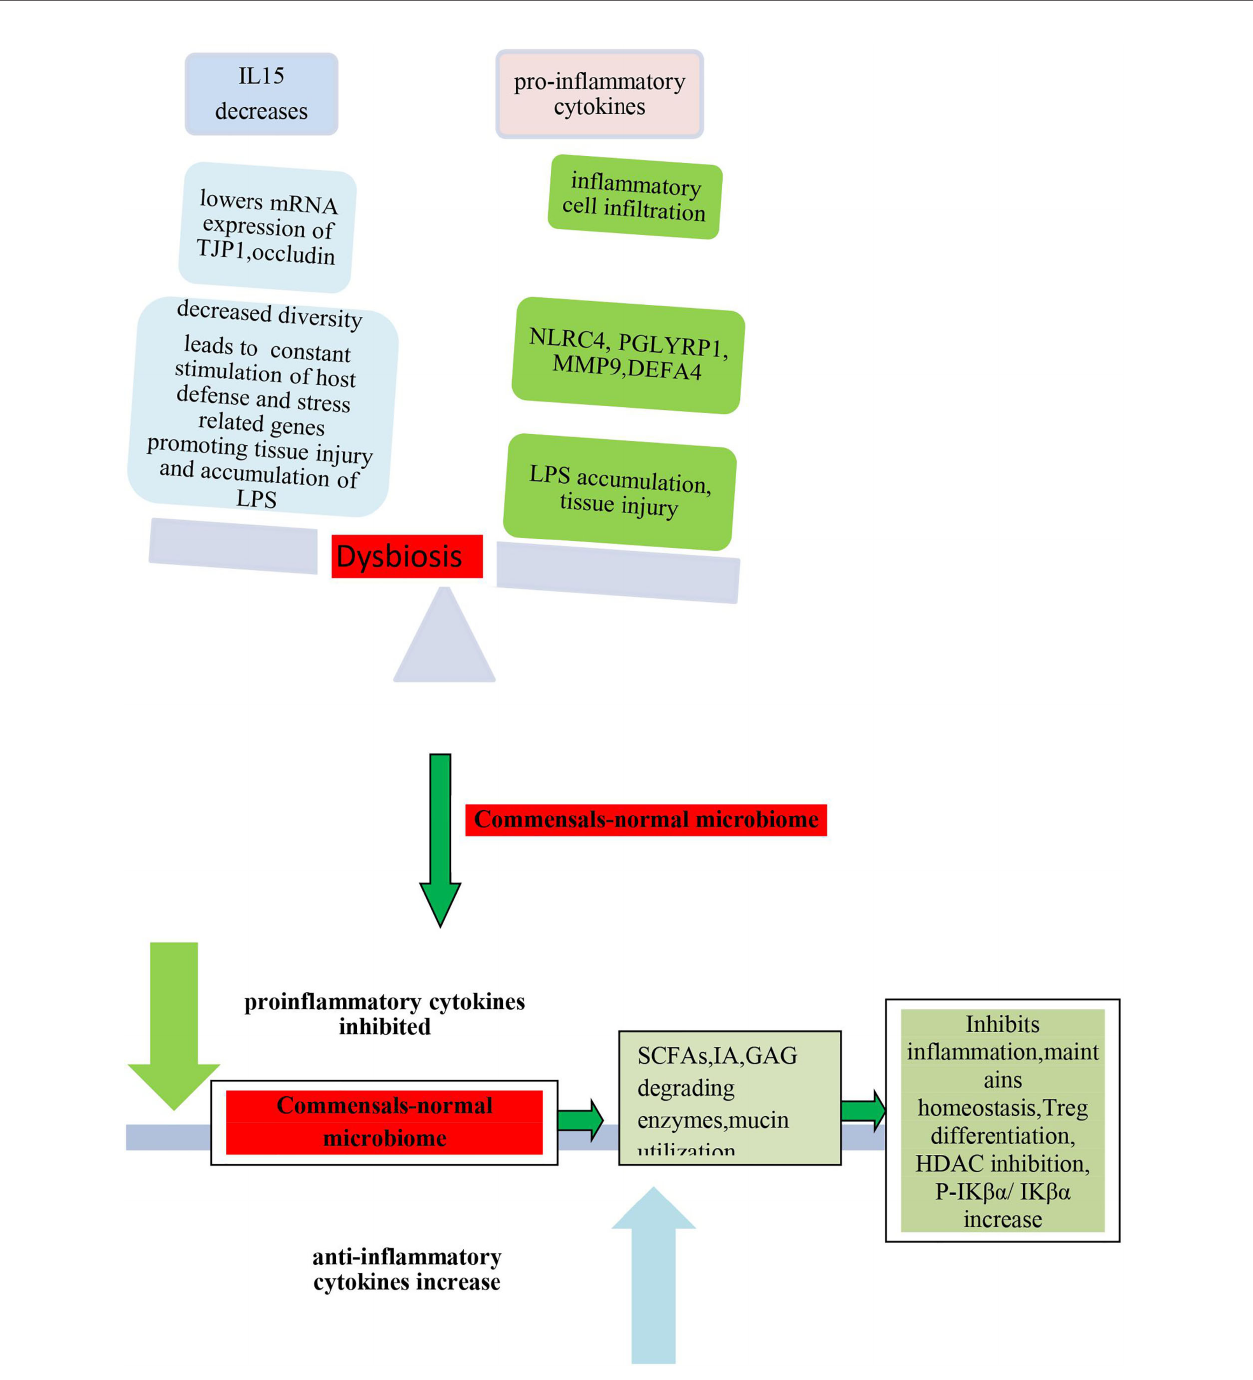
FIGURE 3 | The fi gure provides an outline of various proin fl ammatory cytokines and growth factors produced as a result of dysbiosis of the microbiome indicating the crucial role that the microbiome plays in the initiation of in fl ammation leading to oversecretion of proin fl ammatory cytokines like IL6, IL-1 b , CXCL8, IL-17a, IL1Ra, MIP-1 a , G-CSF, VEGF, EGF, Myd88, p-p65, TLR4, and TNF- a . It shows that decreased diversity of the microbiome favors the expression of defense and stress- related host genes, which are constantly stimulated leading to tissue injury. These include NLRC4, PGLYRP1, MMP9, and DEFA4. This also promotes the accumulation of LPS in certain organs. It has been found from various studies that bene fi cial commensals, if present in the correct proportion, inhibit proin fl ammatory cytokines and promote the secretion of anti-in fl ammatory cytokines, promote Treg differentiation, inhibit HDACs, and increase the epithelial ratio of P-IK ba /IK ba . Indole acrylic acid (IA) produced by commensals promotes barrier function and inhibits in fl ammatory response. Commensals help in immunomodulation, fi ne-tune the balance between pro- and anti-in fl ammatory molecules, and regulate the immune response by regulating the differentiation of different immune cell subsets and by regulating the activity of T reg cells, thereby helping in the maintenance of immune homeostasis.